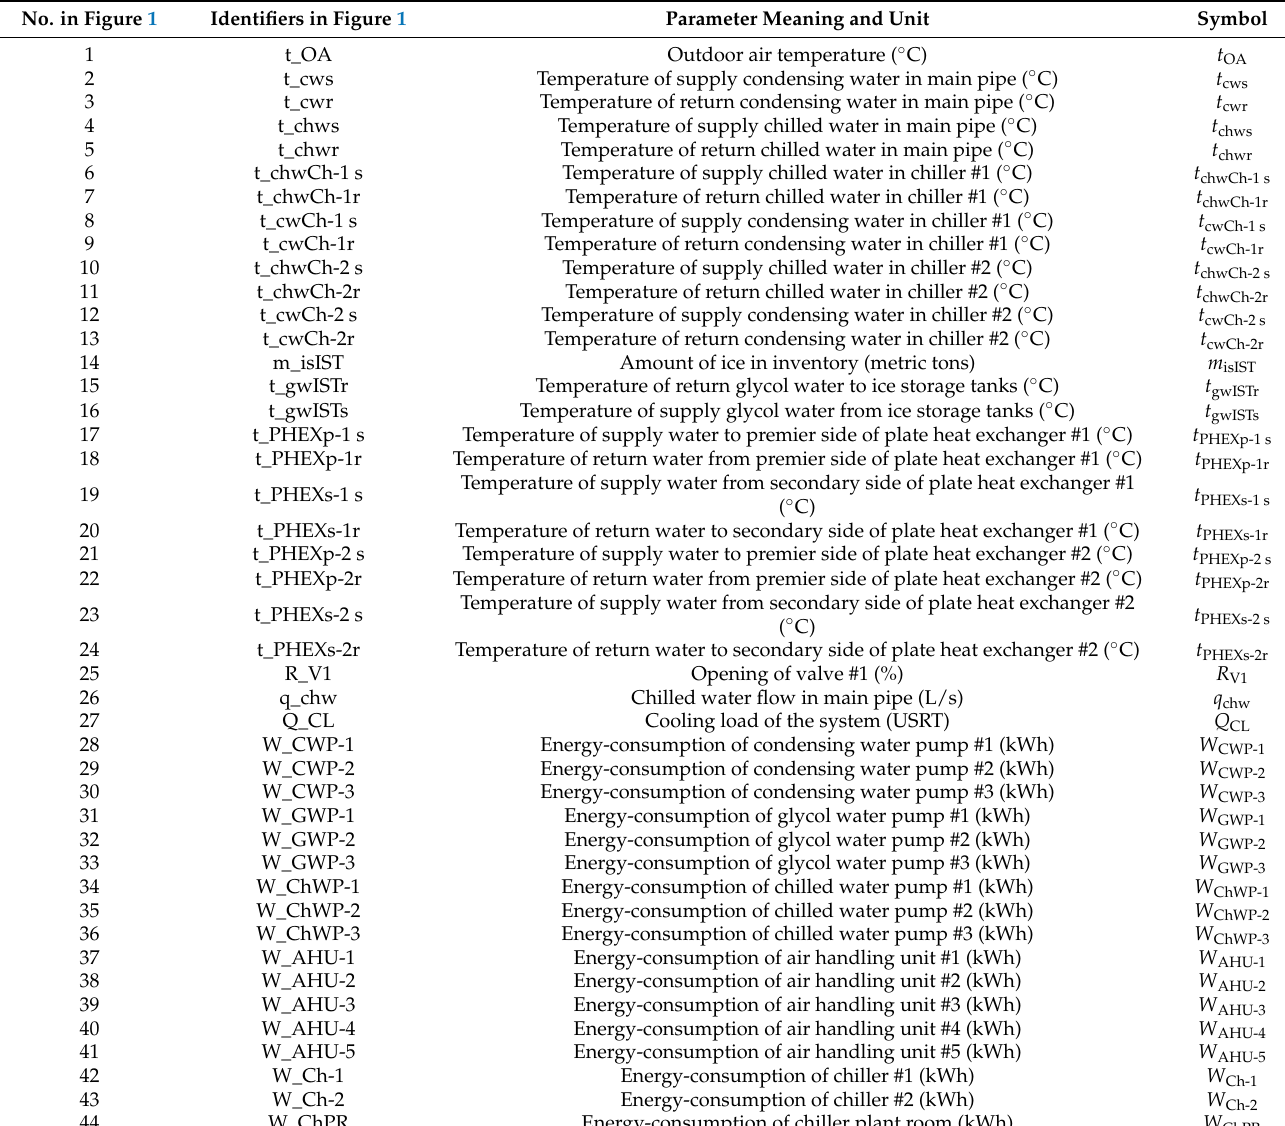
Table 2. Parameters monitored in the case